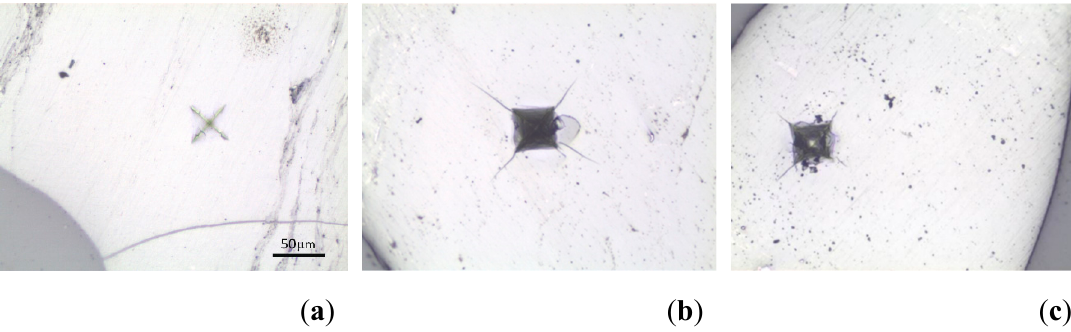
Figure 8. Methane sorption isotherm resulting from the fitting of the Langmuir model (low-rank coal 143). Highly metamorphized coals are excellent sorbents of methane. Sorption capacity a 1 varies between 2.8 and 4.3 cm 3 CH 4 /g. The maximum sorption capacity a m of these coals varies between approximately 23.5 and approximately 26 cm 3 CH 4 /g. In the case of low-rank coals, the sorption capacity a 1 does not exceed 2.5 cm 3 CH 4 /g, while the maximum sorption of methane for low- and medium-rank coals is not higher than slightly above 19 cm 3 CH 4 /g. At a constant temperature, an increase in methane sorption capacity was observed from lower rank coals towards those with a higher degree of metamorphism. According to [12], the minimum of sorption capacity value falls on the reflectance R 0 around 1.0, which corresponds to the lowest volume of micropores in dry coals (see Table 1). In the case of high-rank coal samples, the kinetics included approximately 150 h of the saturation process (Figure 7), while in the case of low- and medium-rank coal samples, methane sorption takes less than 20 h. The variation ranges of the effective diffusion coefficient D e in the group of highly metamorphized coals correspond to the range of 1.13 × 10 − 10 cm 2 /s to 3.46 × 10 − 10 cm 2 /s. In the group of medium-rank coals, the value of effective diffusion coefficient D e varies between 4.00 × 10 − 10 cm 2 /s and 9.77 × 10 − 10 cm 2 /s, while in the group of low-rank coals, it varies between 4.18 × 10 − 10 cm 2 /s and 8.90 × 10 − 10 cm 2 /s. At 20 °C, medium-rank coals show the best ability to transport methane (Table 1). Undoubtedly, the degree of metamorphism significantly influences the development of the porous structure of coal, which affects the kinetics of sorption processes [8,13].